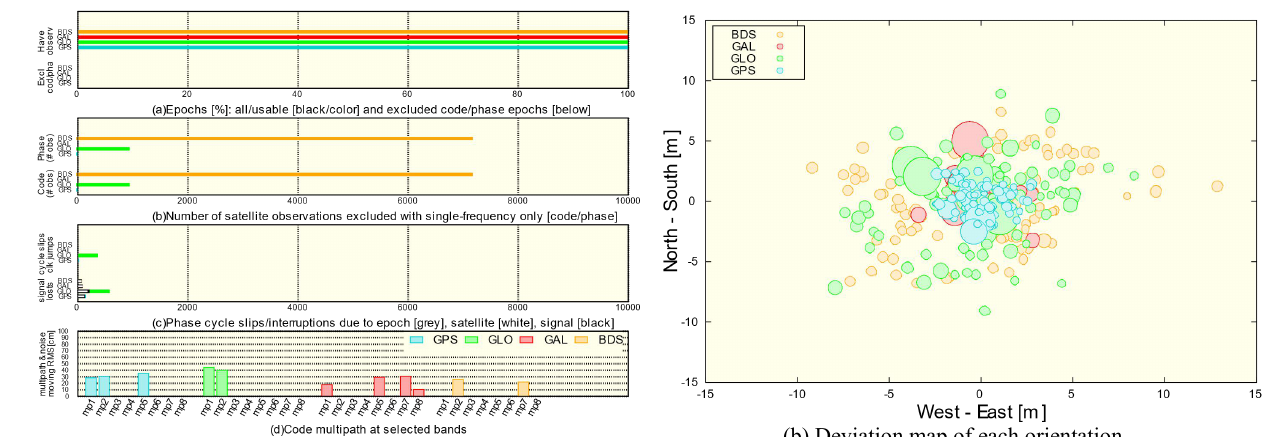
Figure 5. Overall statistical chart of observed data quality